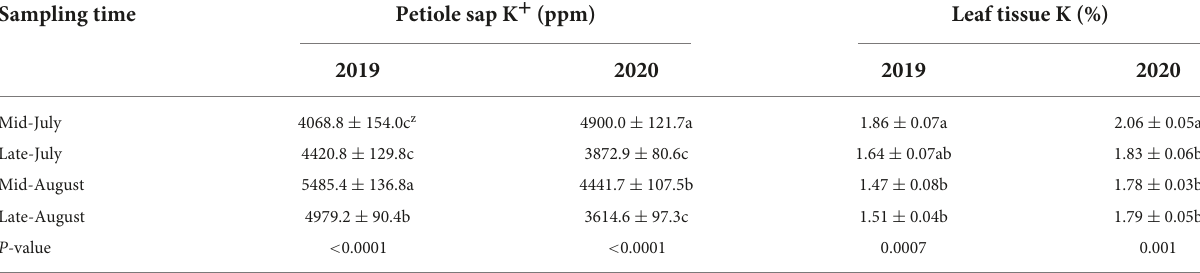
TABLE 3 “Meeker” floricane red raspberry petiole sap potassium (K + ) and leaf tissue K concentrations by sampling time, 2019 and 2020. Sampling time Petiole sap K + (ppm)